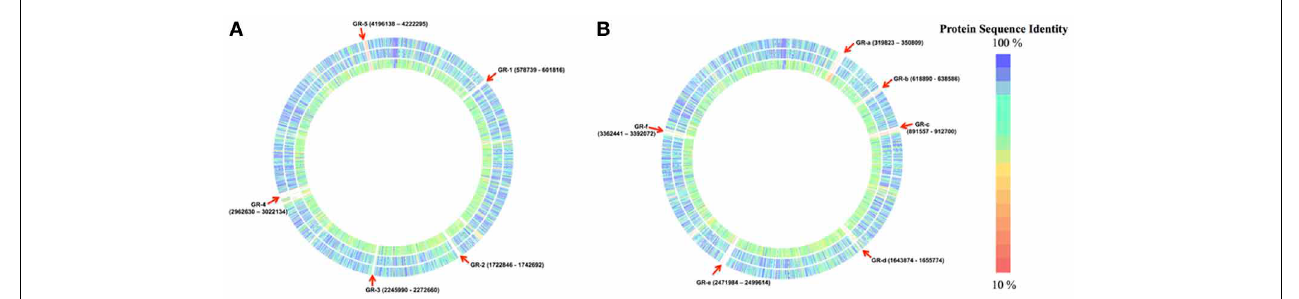
FIGURE 1 | Genomic regions of C. sakazakii SP291 compared to three completed genomes consists of C. sakazakii ATCC BAA 894, C. sakazakii ES15, and C. turicensis z3032. (A) Regions absent in the genome of C. sakazakii SP291 compared to the other three genomes. Reference genome: C. sakazakii ATCC BAA-894; Outer circle: C. sakazakii ES15; Middle circle: C.